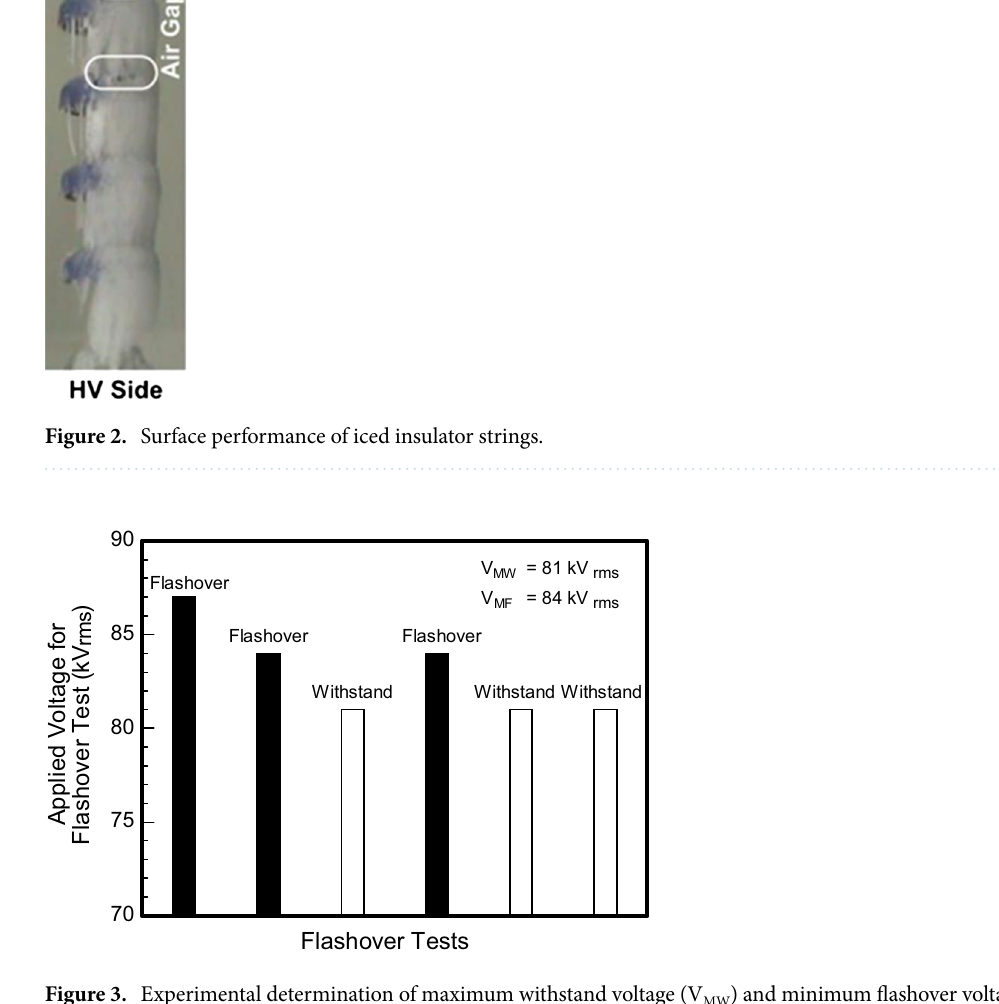
Figure 3. Experimental determination of maximum withstand voltage (V MW ) and minimum flashover voltage (V MF ) from flashover